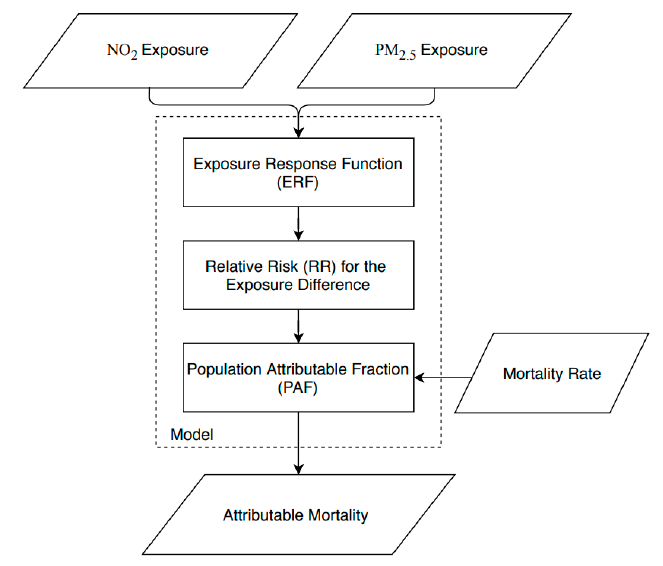
Figure 2. Burden of disease assessment framework.